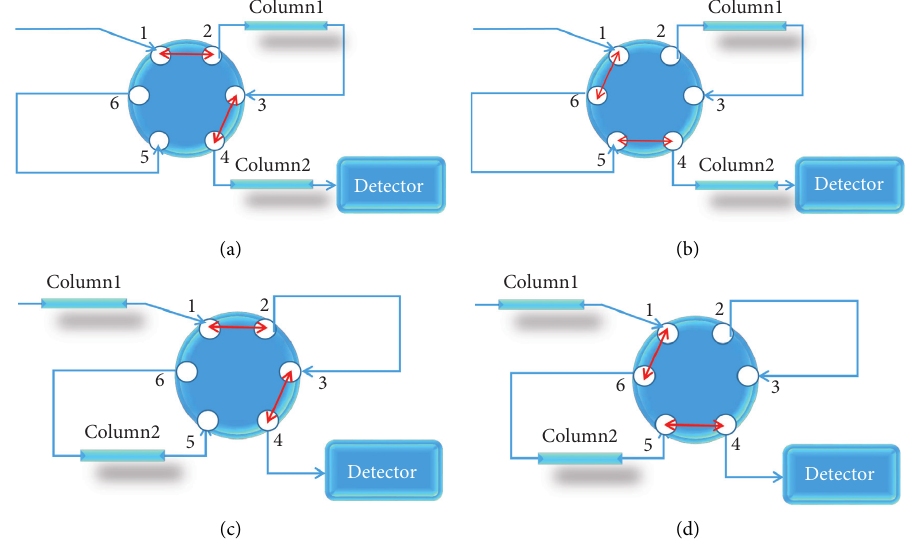
Figure 1: Chromatographic column-connection method of column switching technology based on a single